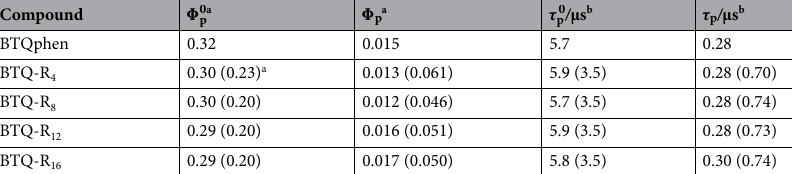
Table 1. Phosphorescence quantum yield and lifetime of BTQphen and BTQ-R n (n = 4, 8, 12, 16) in MeCN and Tris–HCl buffer (pH 7.0). a At room temperature. b At 37 °C. c In parentheses are in Tris–HCl buffer (pH 7.0). φ 0 p and τ 0 p denote the phosphorescence quantum yield and lifetime taken for deaerated solutions, φ p and τ p stands for the phosphorescence quantum yield and lifetime taken for aerated